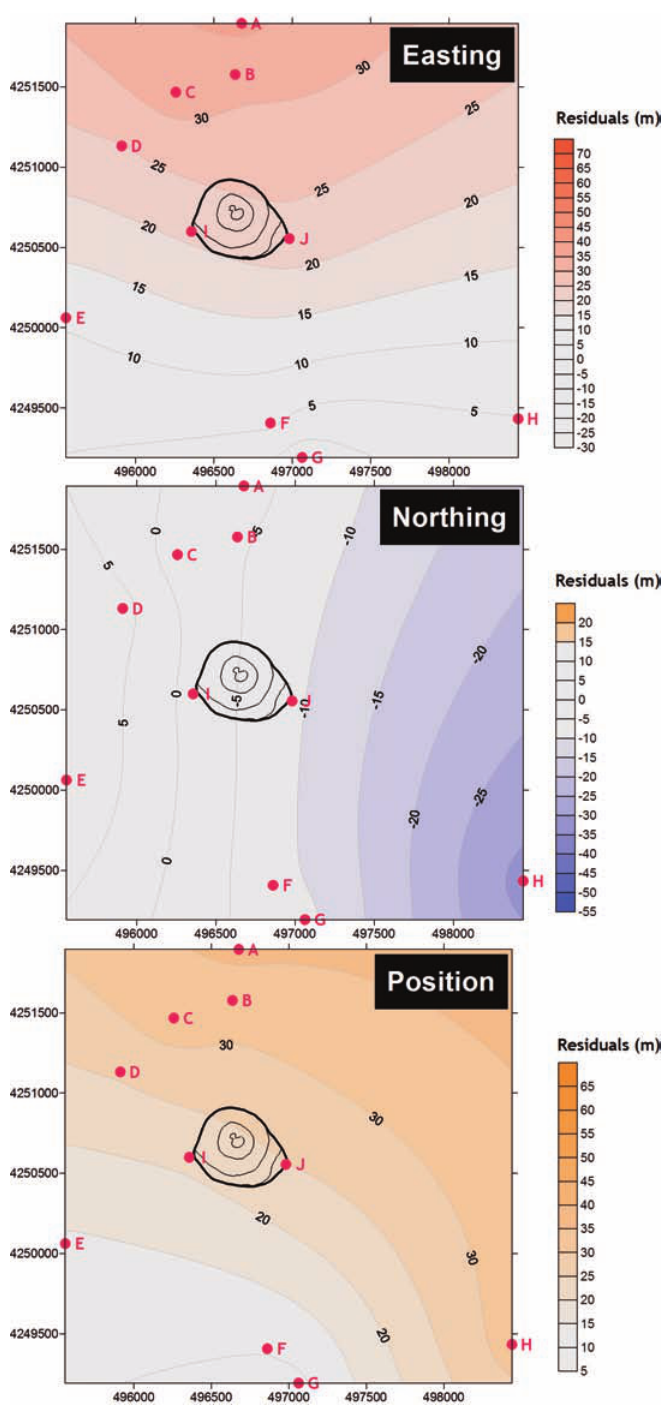
Figure 5. Maps of Easting, Northing and position residuals between the measured and calculated UTM WGS 1984 coordinates for the differential GPS survey of August 28, 2008, at Vulcano Island. Thick black line, the La Fossa crater rim; gray lines, elevation contour lines (10 m contour interval). Red circles (A-J), GPS points.